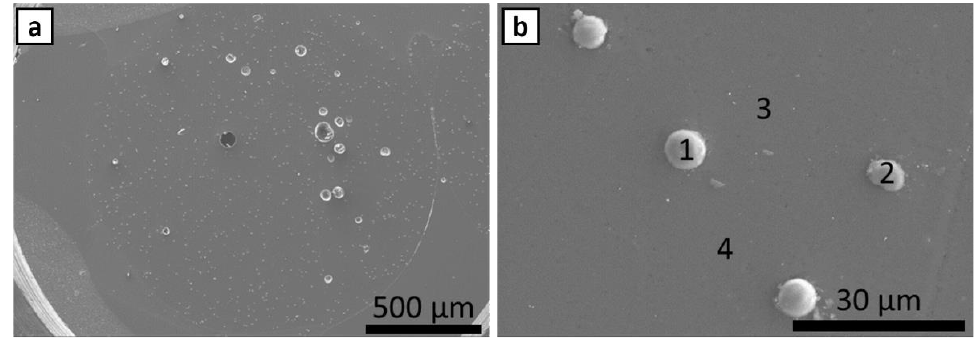
Figure 2. ( a ) FE SEM image of ABS w/5%CF. Numbered areas in ( b ) underwent EDS analysis.